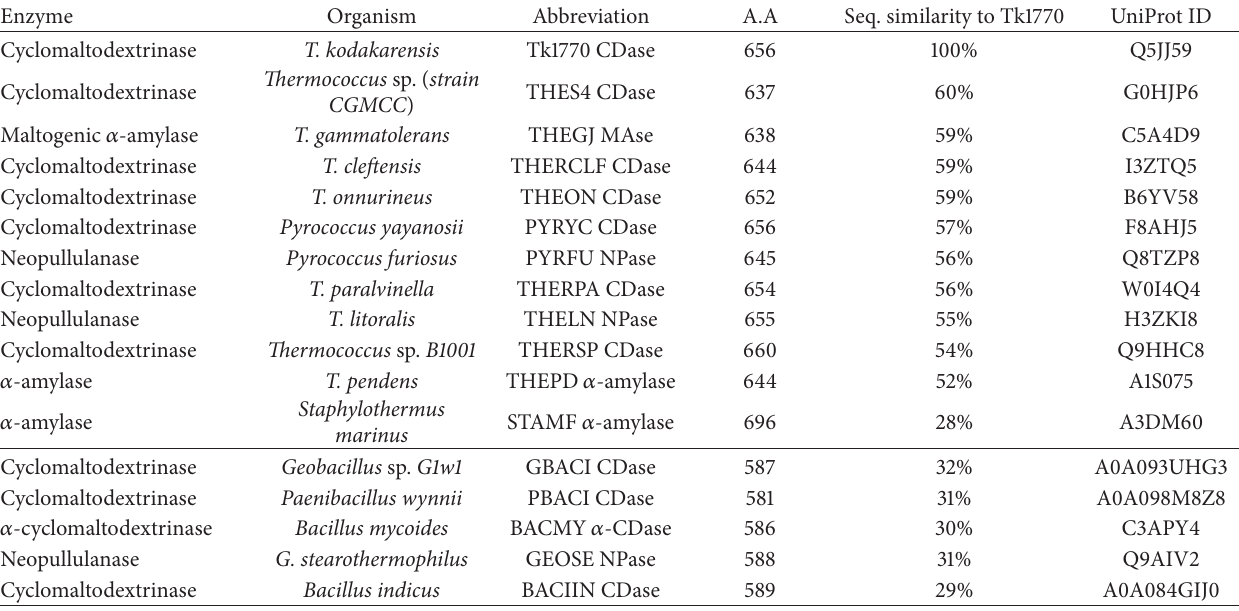
Table 1: List of the sequences used for alignment and